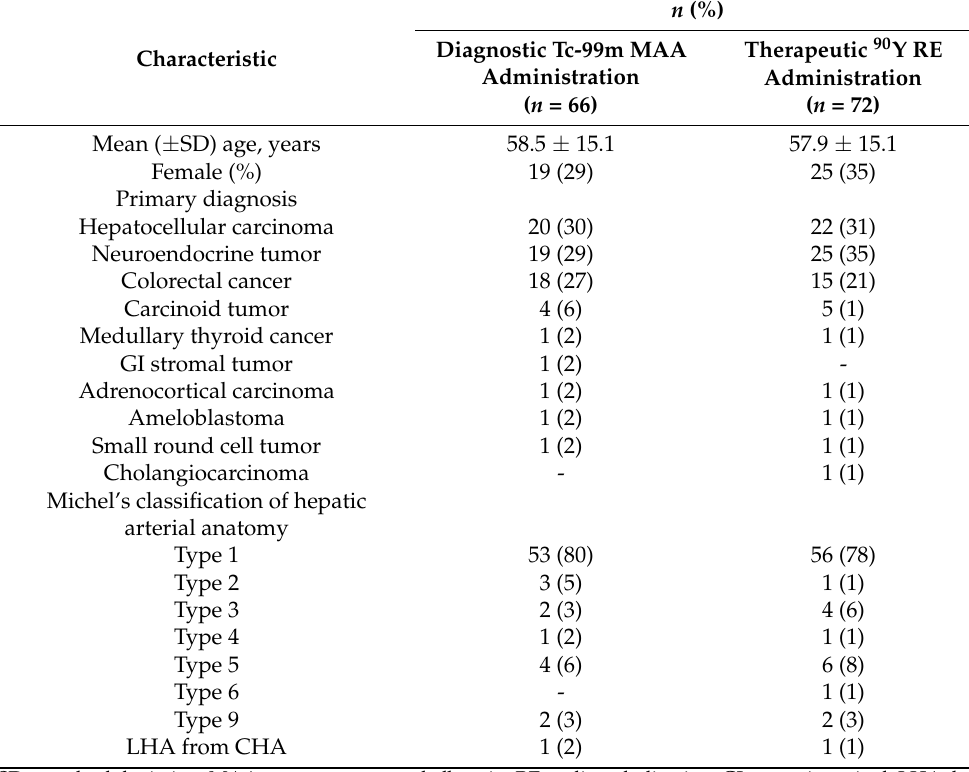
Table 1. Characteristics of the study